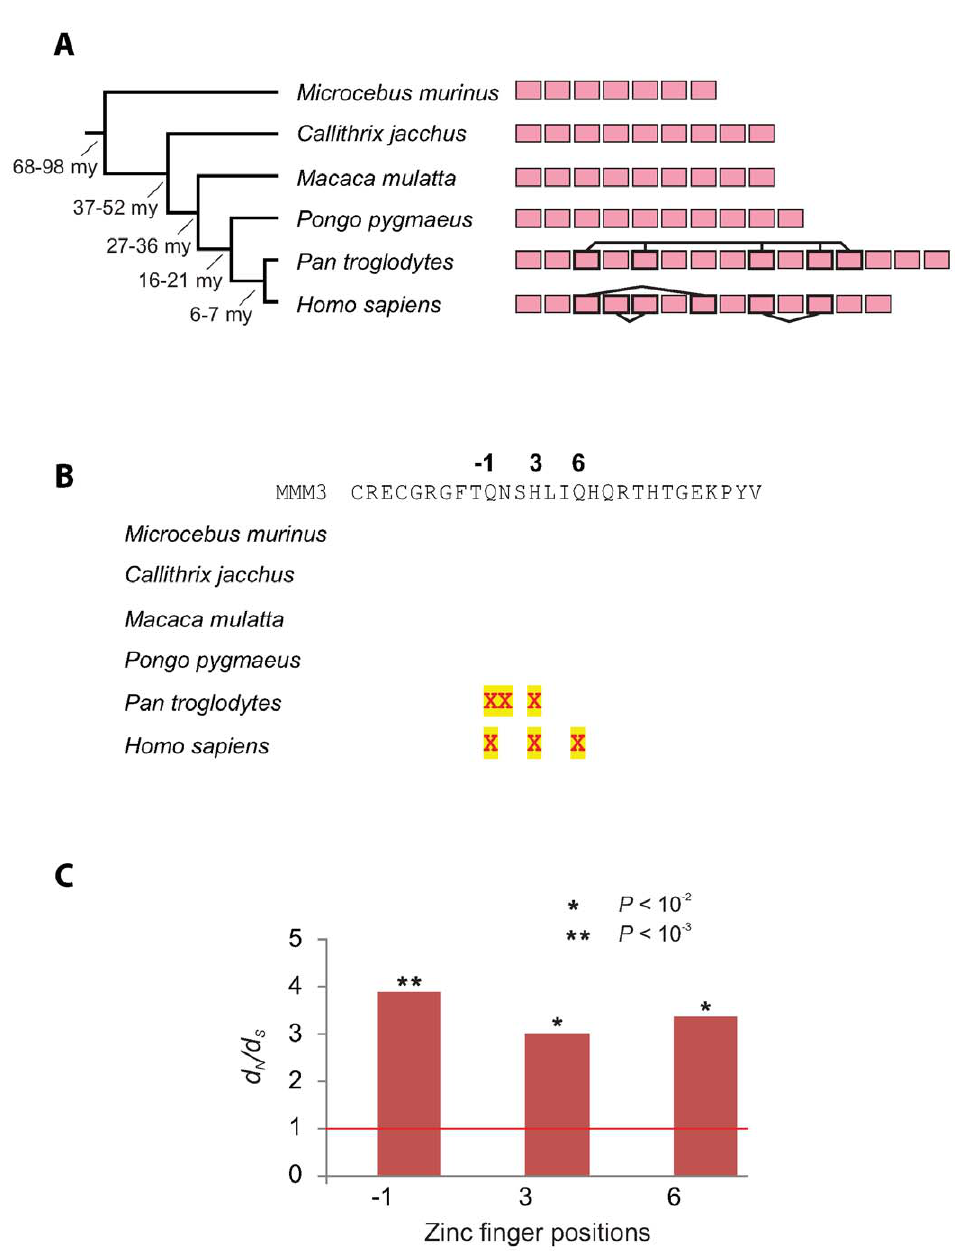
Figure 4. Concerted evolution and positive selection among primate PRDM9 genes. (A) PRDM9 C-terminal zinc fingers for 6 primate species are shown as pink rectangles. Zinc fingers whose nucleotide sequences are identical are joined by solid lines. Zinc fingers with identical sequences from the same species are consistent with gene conversion and/or intra-exon duplication. (B) Predicted positively selected sites in Prdm9 from divergent primate lineages. Positive selection was inferred for each species [27] from intra-species Prdm9 zinc finger sequence alignments. Positively selected sites ( P , 0.05 after multiple testing correction) are shown mapped to the third mouse Prdm9 zinc finger sequence (MMM3) as shown in Figure 3A. (C) Estimated d N /d S values at three zinc finger positions (namely 2 1, 3, and 6) in a comparison of zinc fingers from all primates for which there exists strong evidence of positive selection [27]. The P -values shown have been corrected for multiple testing. Common names to species are listed in the legend to Figure